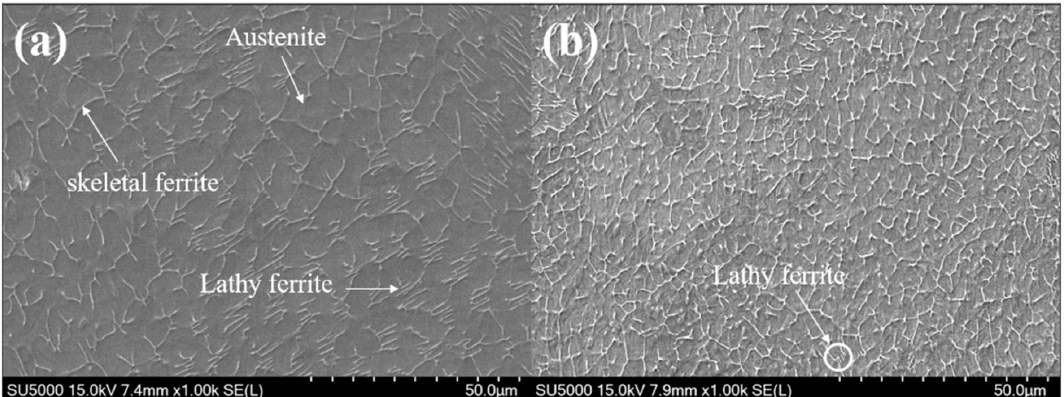
Figure 5. Optical micrographs showing microstructure in weld area cross section for specimen pre ‐ pared via underwater laser welding with a laser power of 2 kW. The three right ‐ most panels show expanded views of areas outlined by dashed red lines in the left ‐ most panel. ( a ) enlarged a, ( b ) enlarged b, ( c ) enlarged c.